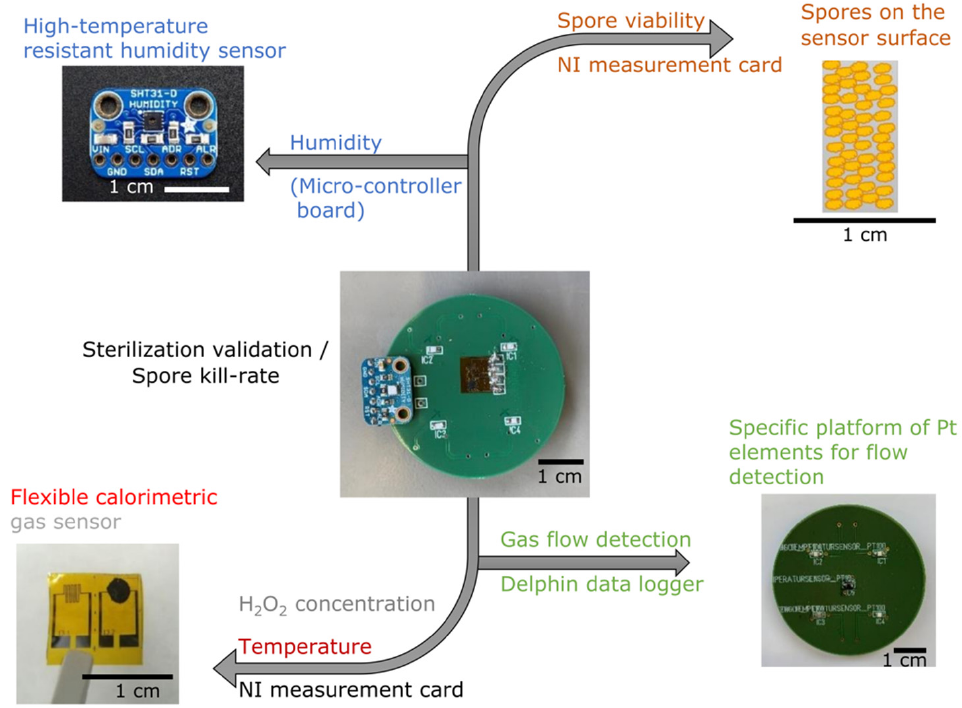
Figure 1. The critical process parameters in sterilization validation that were monitored by means of the developed multi-sensing platform.